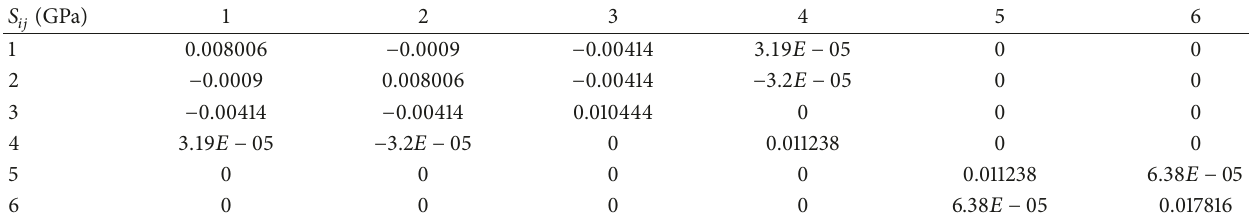
Table 4: Flexible stiffness matrix of quartz crystal.